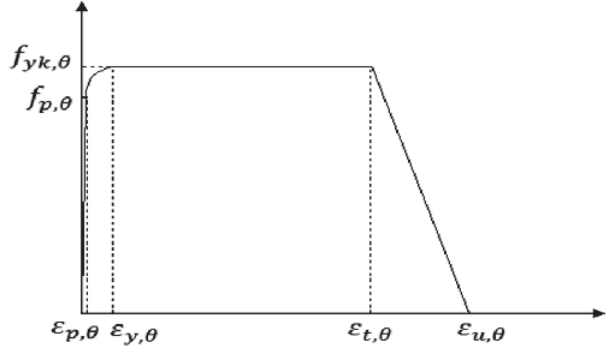
Figura 11 Diagrama tensão-deformação do aço em situação de